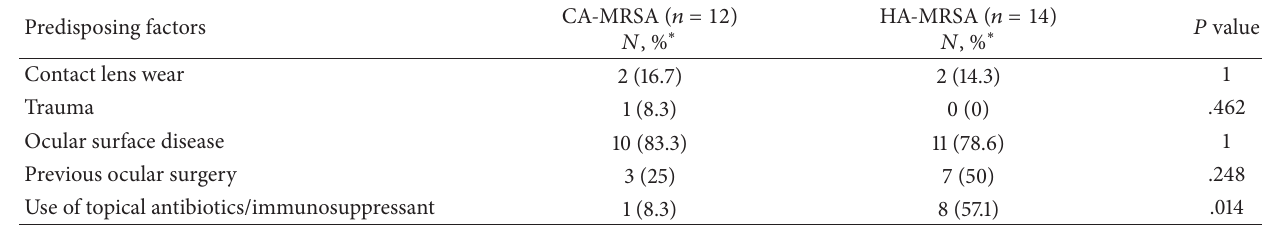
Table 3: Predisposing factors for community-associated (CA) methicillin-resistant Staphylococcus aureus and healthcare-associated (HA) methicillin-resistant Staphylococcus aureus keratitis.